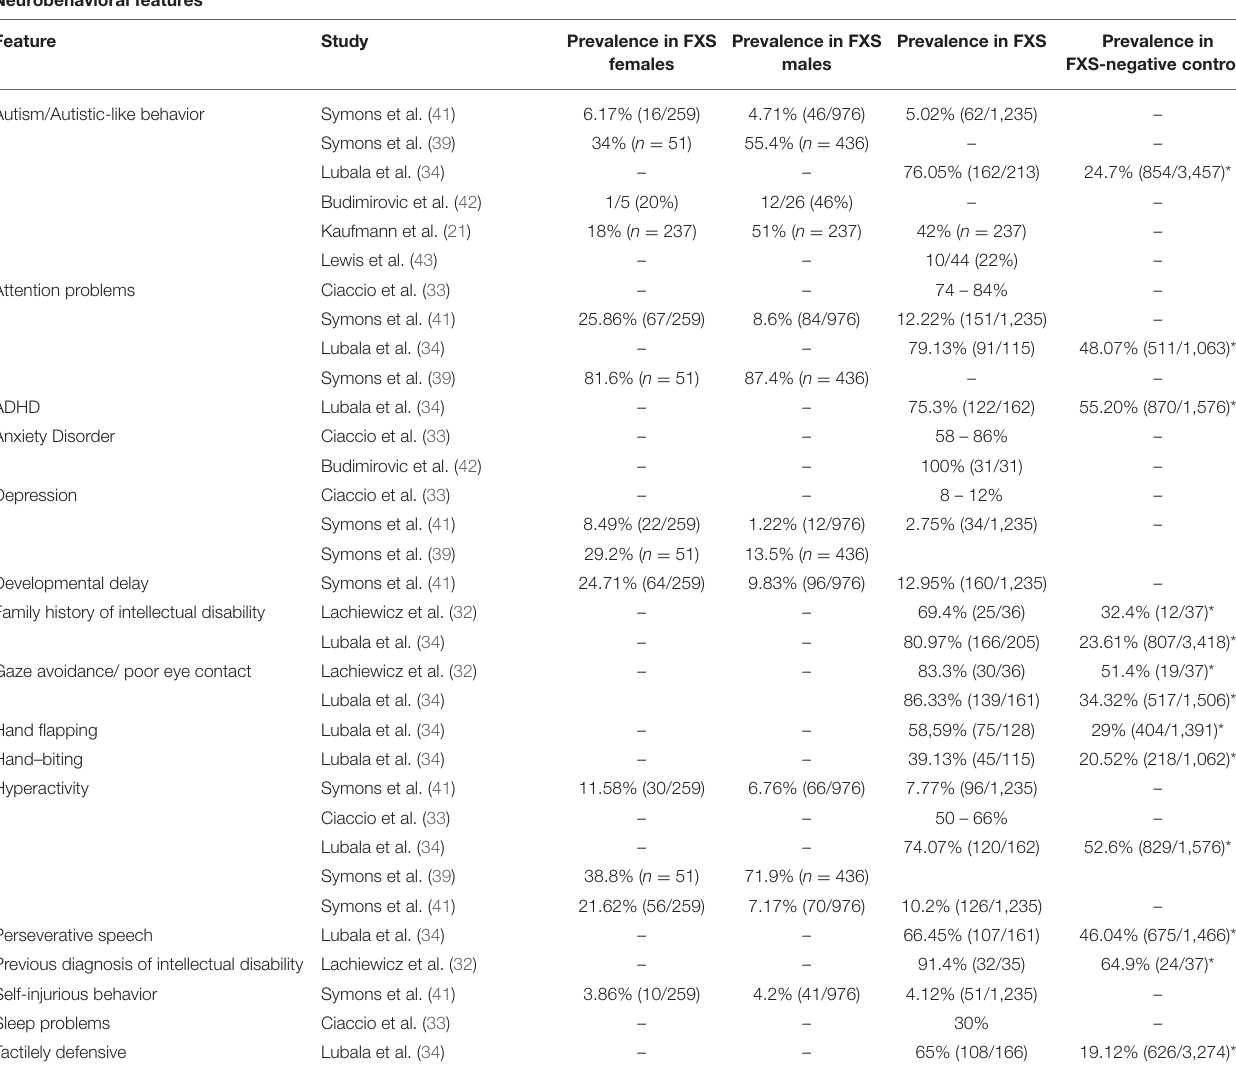
TABLE 2 | Reported prevalence of heterogeneous neurobehavioral features in FXS patients in several